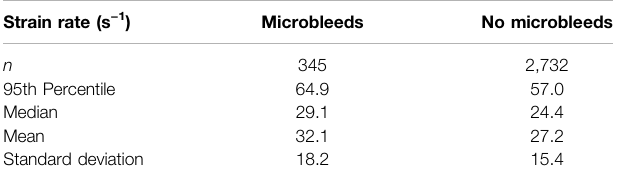
TABLE 2 | Summary statistics of strain per microbleed and non-microbleed grouped